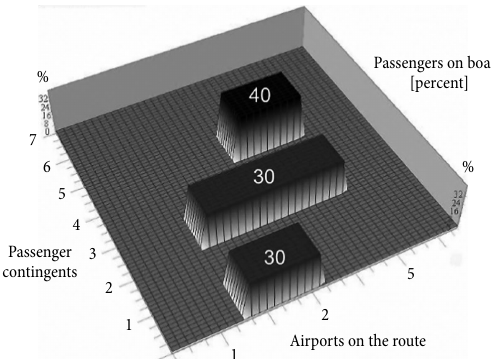
Fig. 3. The optimal route with passengers on board (loads) in percent of total capacity of airplane